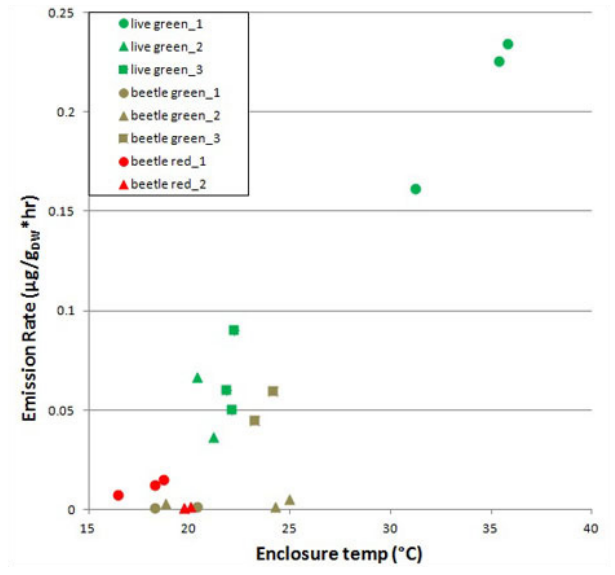
Fig. 2. SQT emissions observed at Chimney Park, WY, during mid- September,